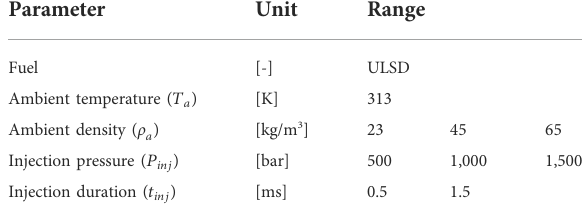
TABLE 5 Experimental test